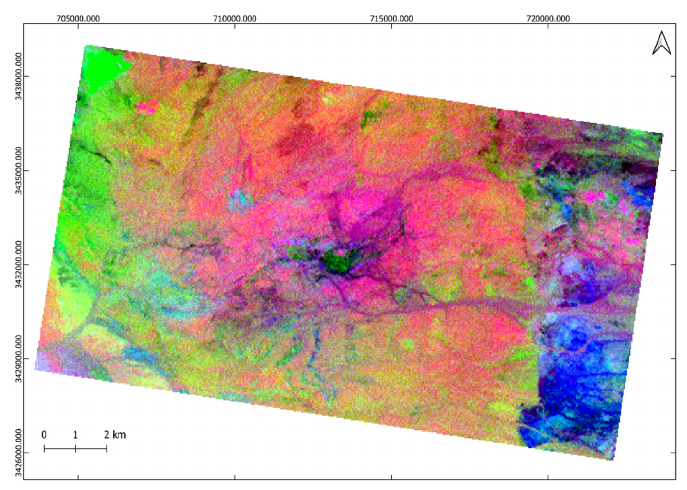
Figure 6. Color combination of MNF bands 1–3 for the study area (Thresholds: >0.43, 0.41, 0.37 for bands 1–3, respectively).